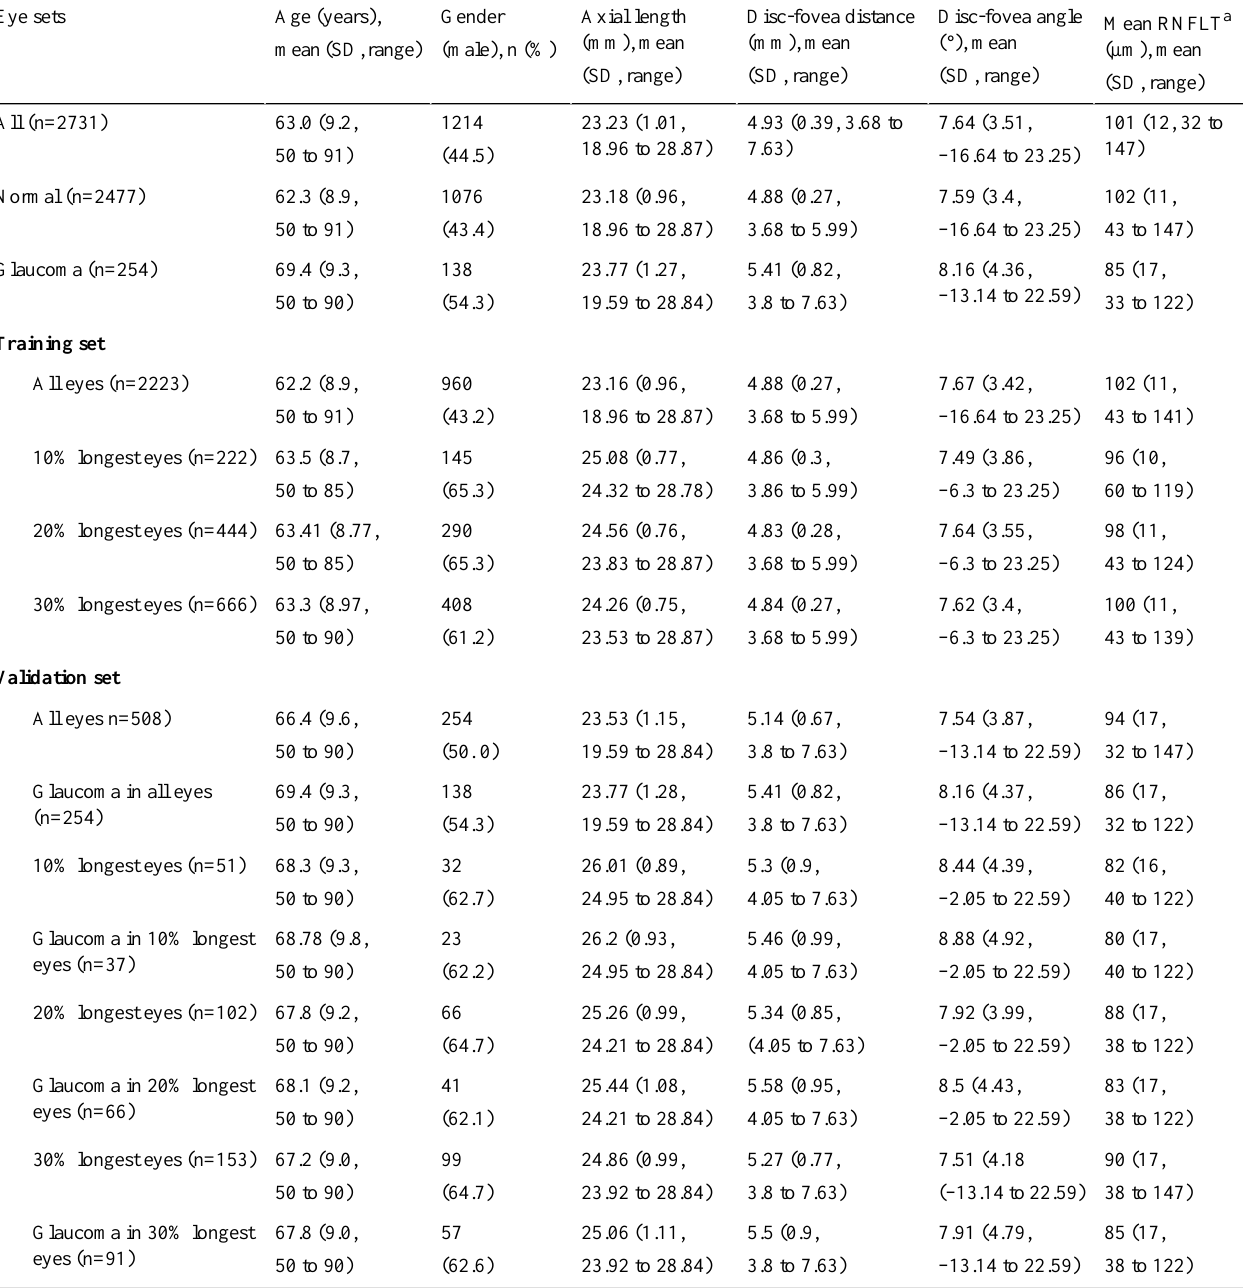
Table 1. Demographic and ocular parameters of the study